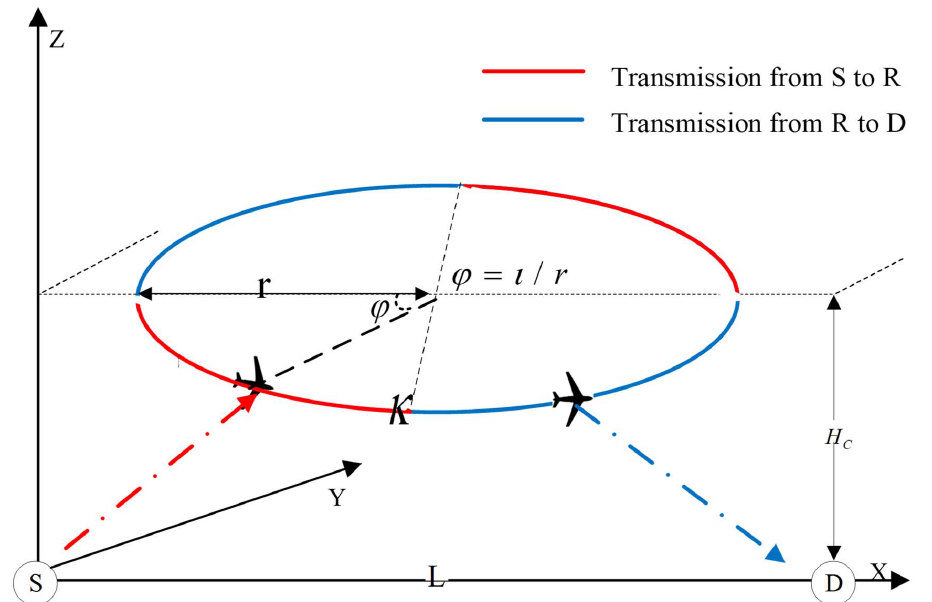
Figure 3. UAV-enabled communication system under circular flight